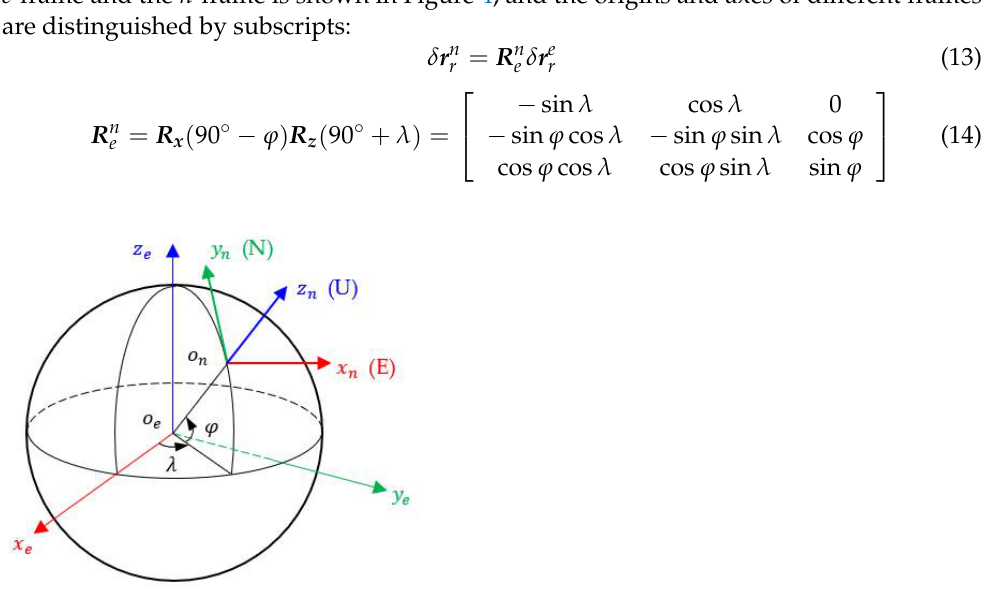
Figure 4. Relationship between the Earth-centered-Earth-fixed (ECEF) frame and the east-north-up (ENU) frame, with letters distinguished with subscripts e and n , respectively.